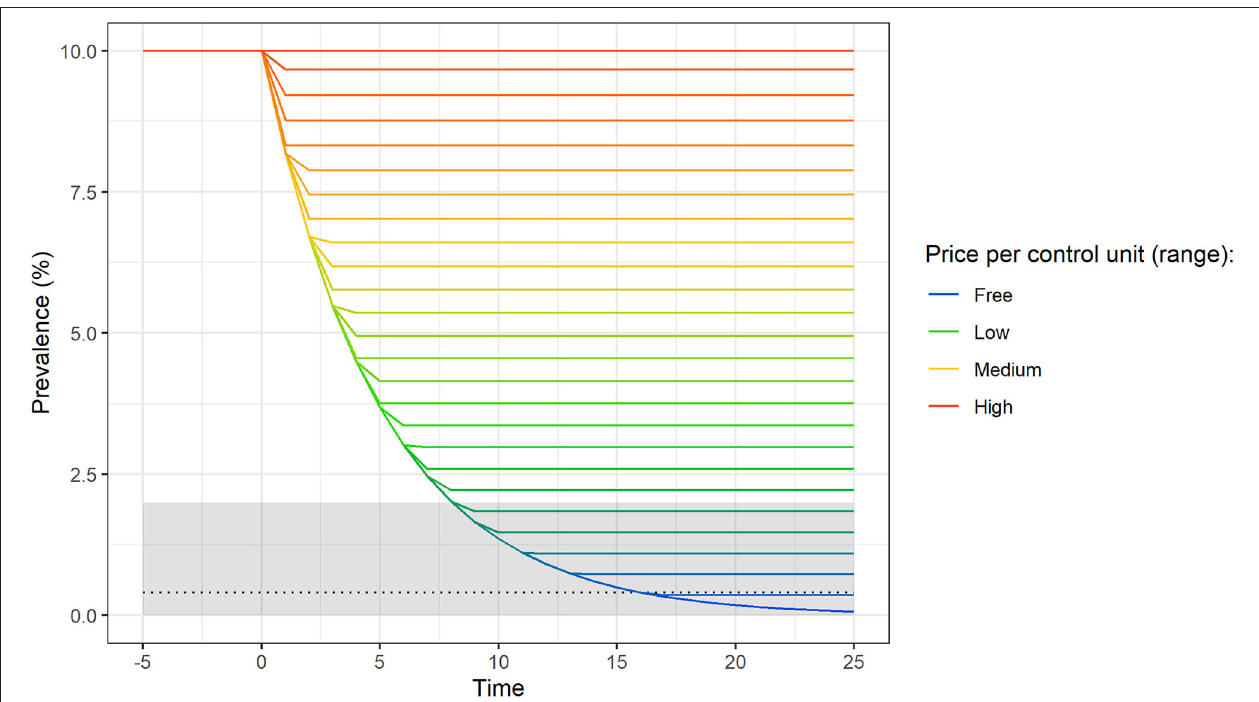
FIGURE 3 | Disease prevalence over time, assuming privately optimal behavior in a single farm for a range of prices per control unit. This simulation assumes a cost of one infected animal per time step ( δ ) of 50 monetary units. The price of reducing the transmission rate by 1% ( θ ) ranges from “Free” (0.00 monetary units) to “High” (1.25 monetary units). “Low” and “Medium” correspond to 0.40 and 0.85 monetary units, respectively. Colored lines represent increases by 0.05 monetary units. The gray shaded area indicates the target prevalence level from society’s perspective ( < 2%). The black dotted horizontal line indicates a prevalence consistent with disease elimination (0.4%; < 1 infected animal in a herd of 250